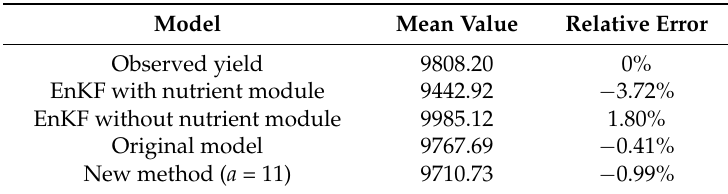
Table 10. Mean yield value (kg/ha) and relative error of different method.